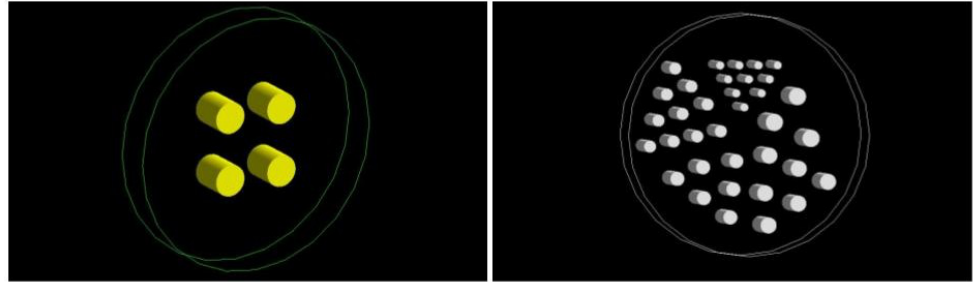
Figure 4. ( Left ): visualization of the cylinder phantom; ( right ): Derenzo